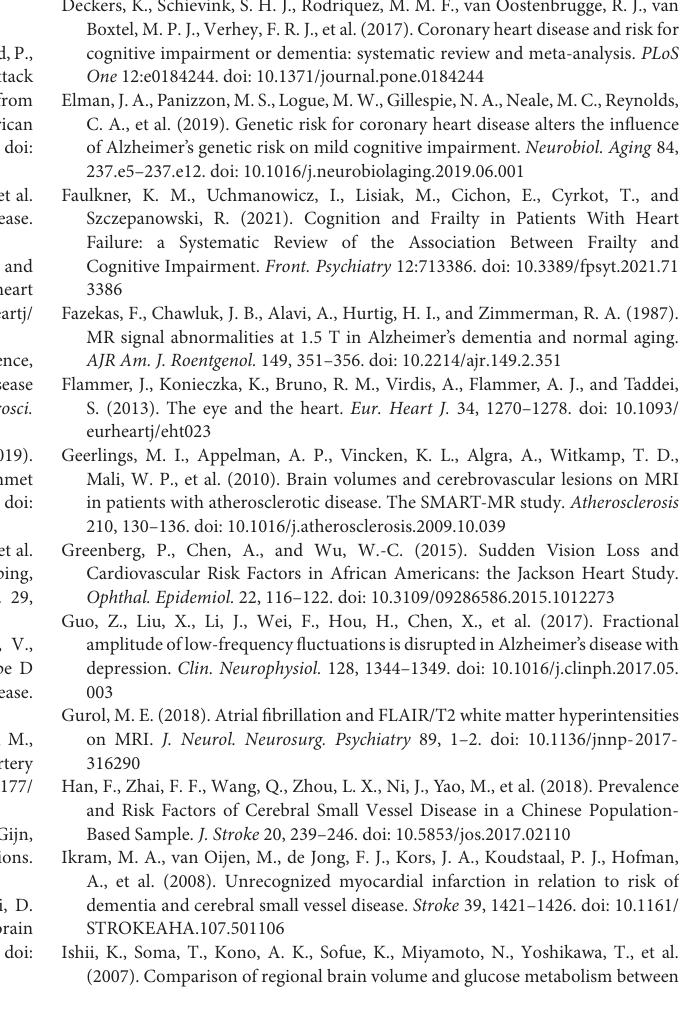
Supplementary Figure 1 | Flow chart of the inclusion of participants for the